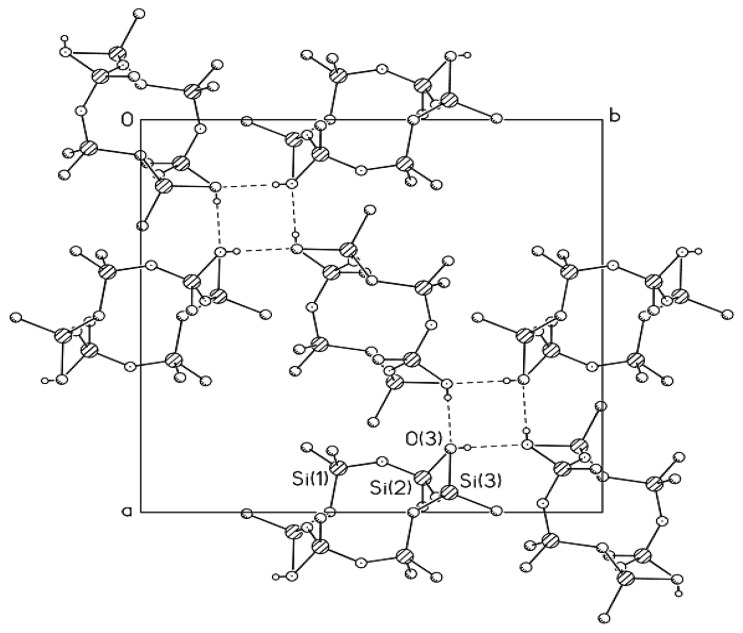
Molecular packing in the crystal of Compound MII-OH (projection on the ab plane). Dashed lines denote intermolecular H-bonds that link molecules to form tetramers.